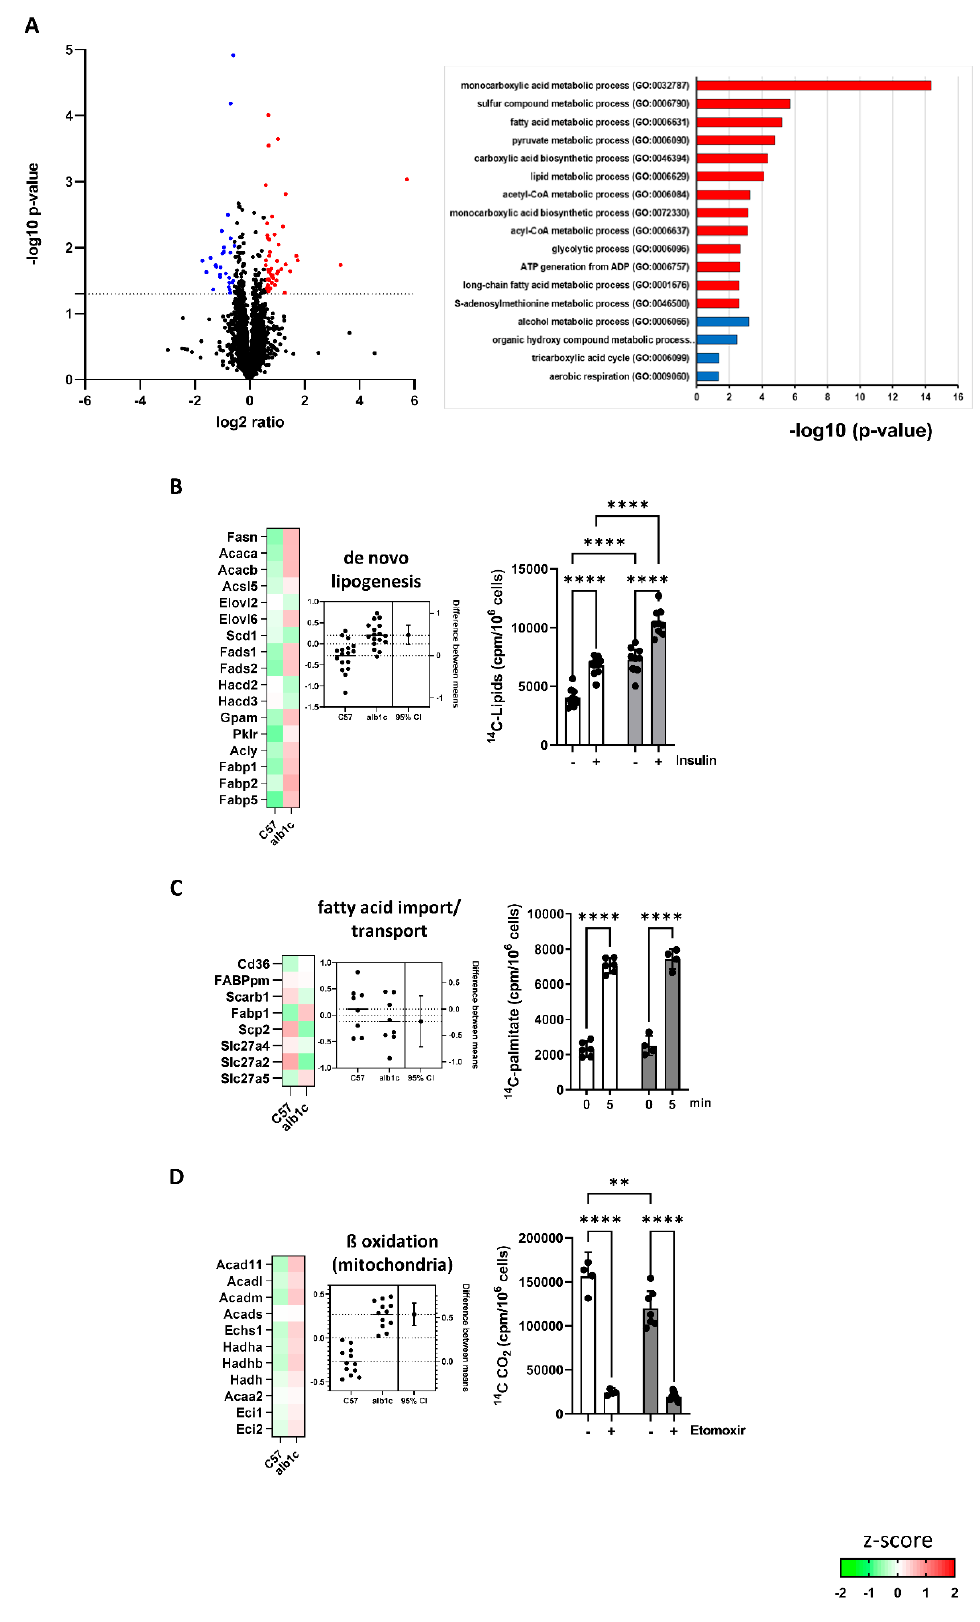
Figure 6. Changes in biosynthesis processes in early-stage MAFLD. ( A ) The log2 fold changes of protein abundance in alb-SREBP-1c vs. C57Bl6 hepatocytes (n = 6 animals per condition). 2731 differentially abundant proteins were detected. Upregulated (red; n = 46) or downregulated proteins (blue; n =